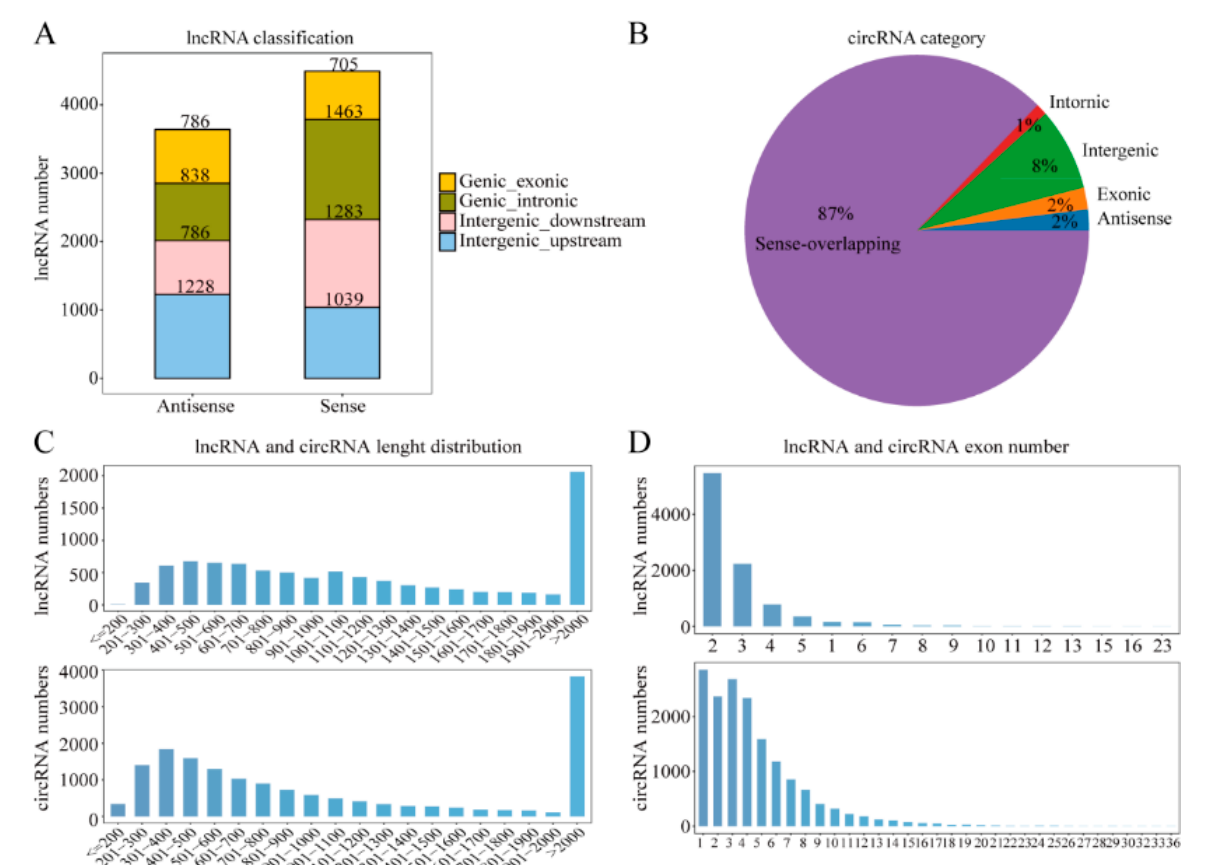
Figure 1. Gene expression characterization. ( A ) The positional relationship between lncRNA and known protein-encoded transcripts counts lncRNA types from four aspects: direction, type, location, and subtype. ( B ) The percentage of five types of circRNAs. ( C ) The length distribution of lncRNAs and circRNAs. ( D ) The number of exons per lncRNA and circRNAs.